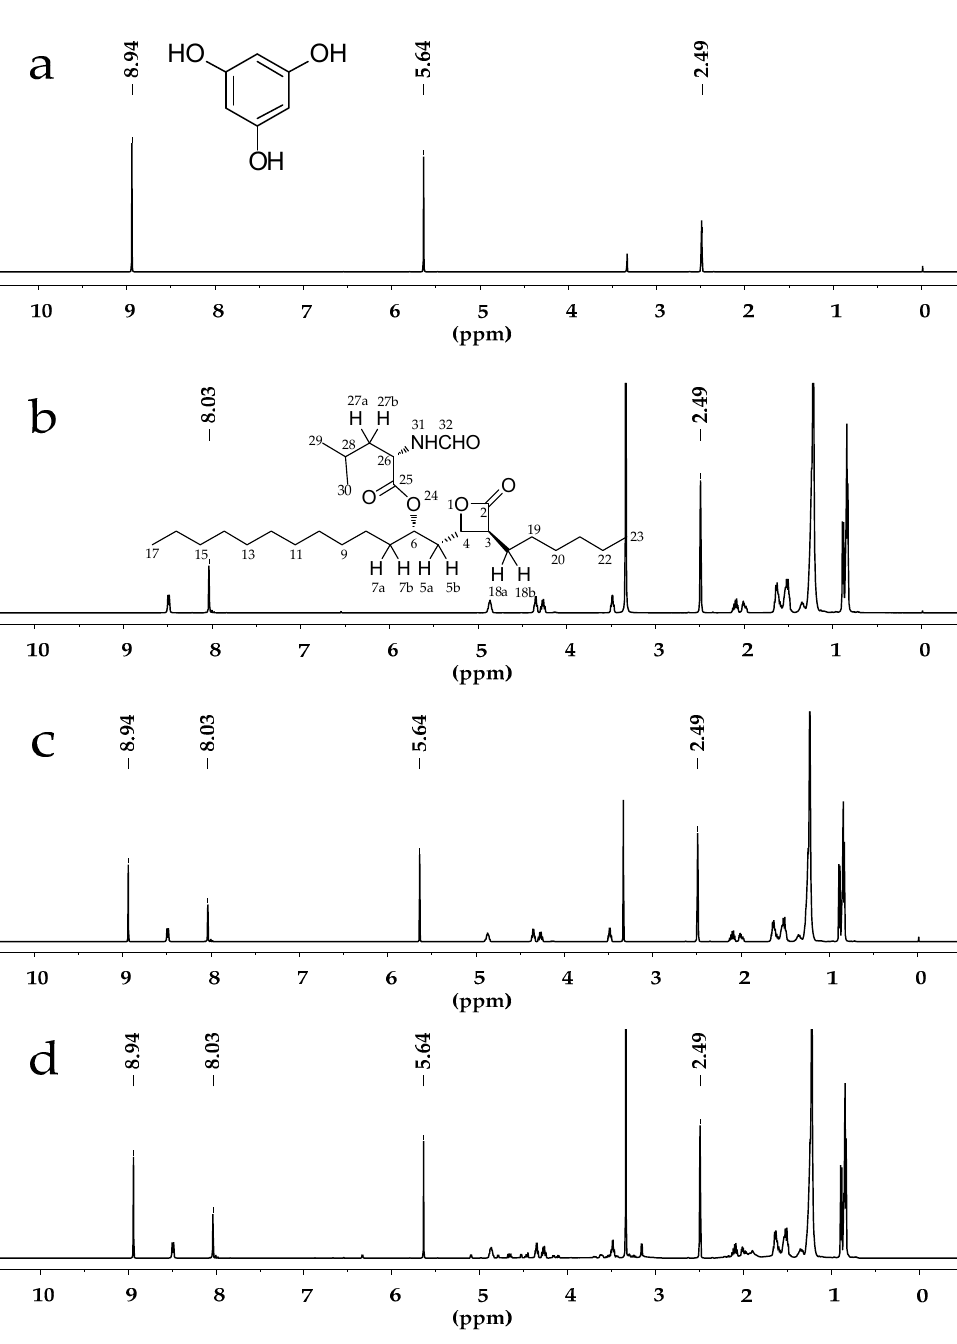
Figure 1. ( a ) 1 H-NMR spectrum of phloroglucinolanhydrous in dimethylsulfoxide- d 6 (DMSO- d 6 ); ( b ) 1 H-NMR spectrum of Orlistat in DMSO- d 6 ; ( c ) 1 H-NMR spectrum of Orlistat and phloroglucinolanhydrous in DMSO- d 6 ; ( d ) 1 H-NMR spectrum of Orlistat tablet powder extractive and phloroglucinolanhydrous in DMSO- d 6 .